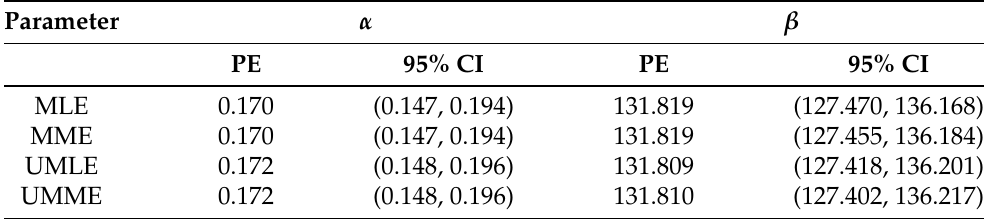
Table 2. Parameter estimates for complete Fatigue Life